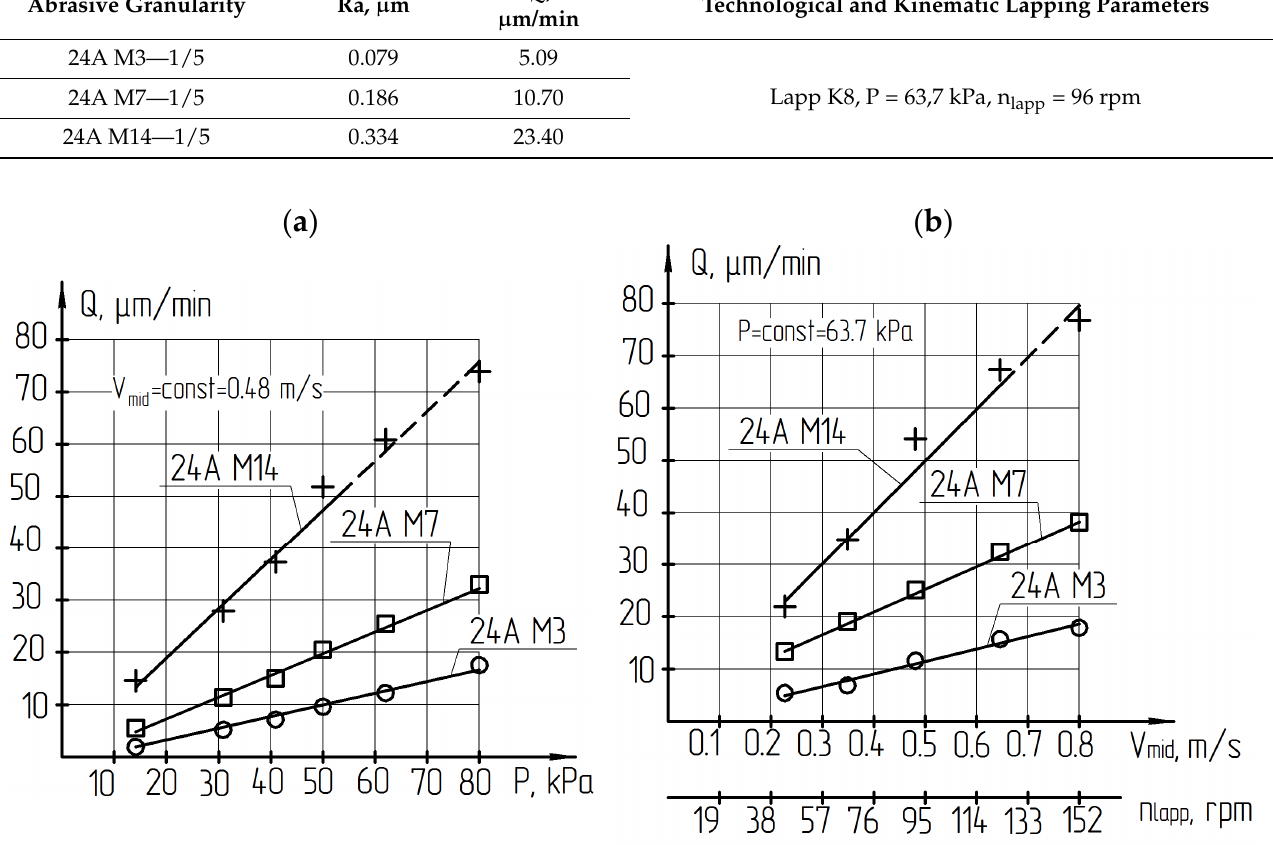
Figure 8. Influence of pressure ( a ) and mid (mean) cutting speed ( b ) on the lapping with a free abrasive productivity.